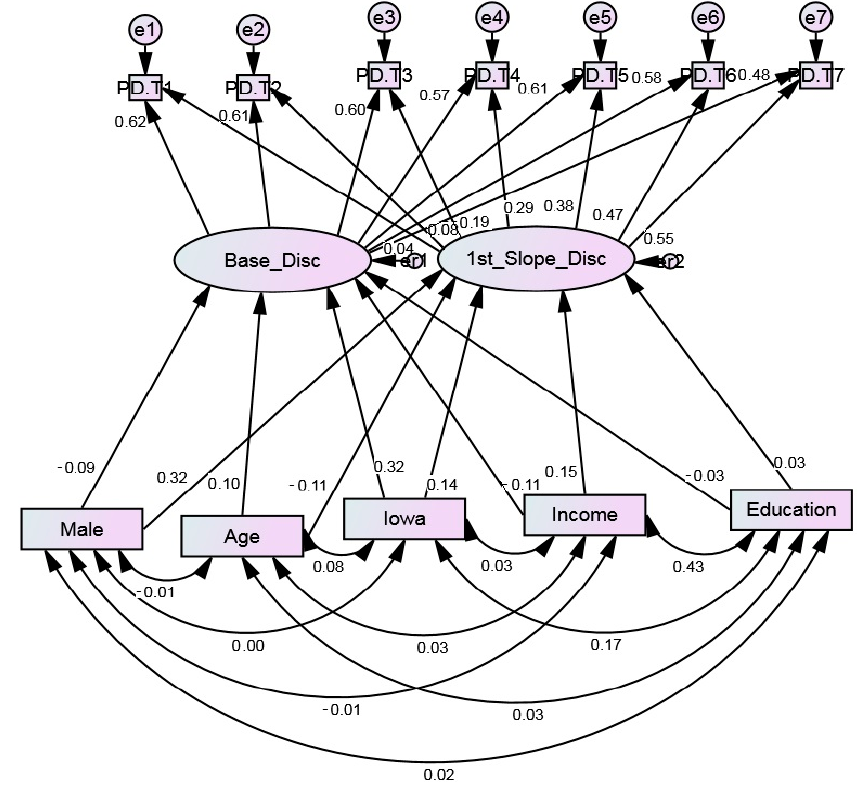
Figure 1. Summary of paths in the latent growth curve model on predictors of perceived discrimination over 18 years ( n = 889). Chi-square = 178.148, Probability level = 0.000, CFI 0.917, CMIN/DF 4.049, df = 44, RMSEA = 0.059 (0.050–0.068).